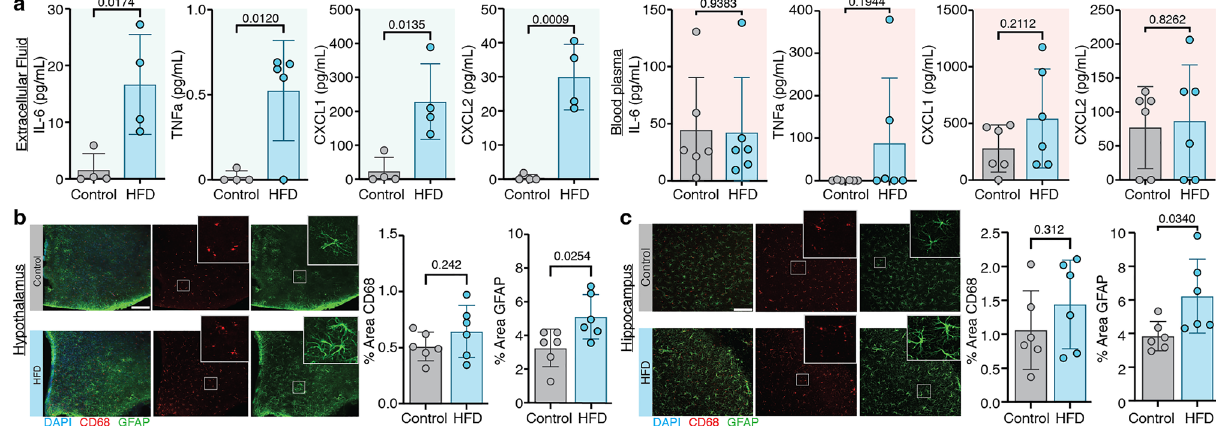
Figure 4. Chronic obesity induces brain inflammation but not peripheral inflammation. ( a ) Cytokine and chemokine profiles of extracellular fluid (green shaded panels) and blood plasma (red shaded panels) for IL-6, TNFα, CXCL1 and CXCL2 of HFD or control mice (n = 4–6; unpaired t-test, IL-6 * = 0.0174; TNFα * = 0.0120; CXCL1 * = 0.0135; CXCL2 *** = 0.009). ( b , c ) Immunohistochemistry of coronal brain slices of HFD and control mice after 44 weeks of diet. Representative images of ( b ) hypothalamus and ( c ) hippocampus regions for the microglial marker CD68 and astrocytic marker GFAP. Quantification of % total area stained for microglial CD68 and astrocytic GFAP marker in ( b ) hippocampus and ( c ) hypothalamus. Scale bars: 50 µm. Graphs shows mean ± SD (n = 6, unpaired t-test, hypothalamus % area GFAP * = 0.0254, hippocampus % area GFAP * = 0.0340). Graphs created with GraphPad software (version 9.0, https:// www. graph pad. com/ scien tific- softw are/ prism/). Figure design in Adobe Illustrator 2022 (version 26.3.1, https:// www. adobe. com/ produ cts/ illus trator/ free- trial- downl oad. html) by Dan